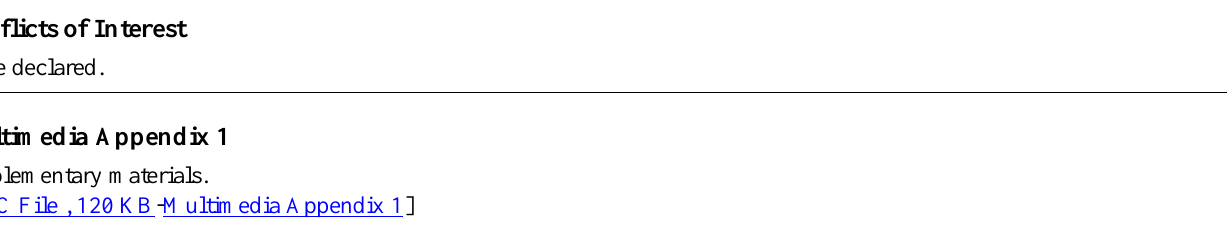
Table S1. Clinical characteristics of hospitalized patients with COVID-19 at baseline. The clinical characteristics of all patients (N=4029) included in this study, including vital signs, metabolic markers, liver function, inflammatory markers, and hematological markers. All laboratory data was obtained within 36 hours of admission. Interhospital comparisons for categorical data were assessed with Chi-square tests. Numerical data were assessed Kruskal-Wallis tests. Bonferroni-adjusted P values are reported. Values relating to <10 patients per field are not provided to protect patient privacy.